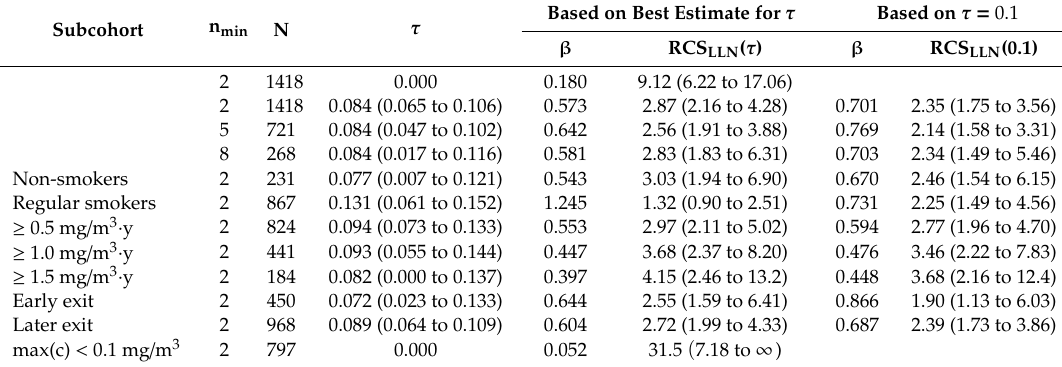
Table 3. Estimates for the reference dose of respirable crystalline silica based on threshold models using mixed-e ff ects maximum-likelihood regression (95%CI in parentheses). Based on Best Estimate for τ Based on τ = Subcohort n min N τ